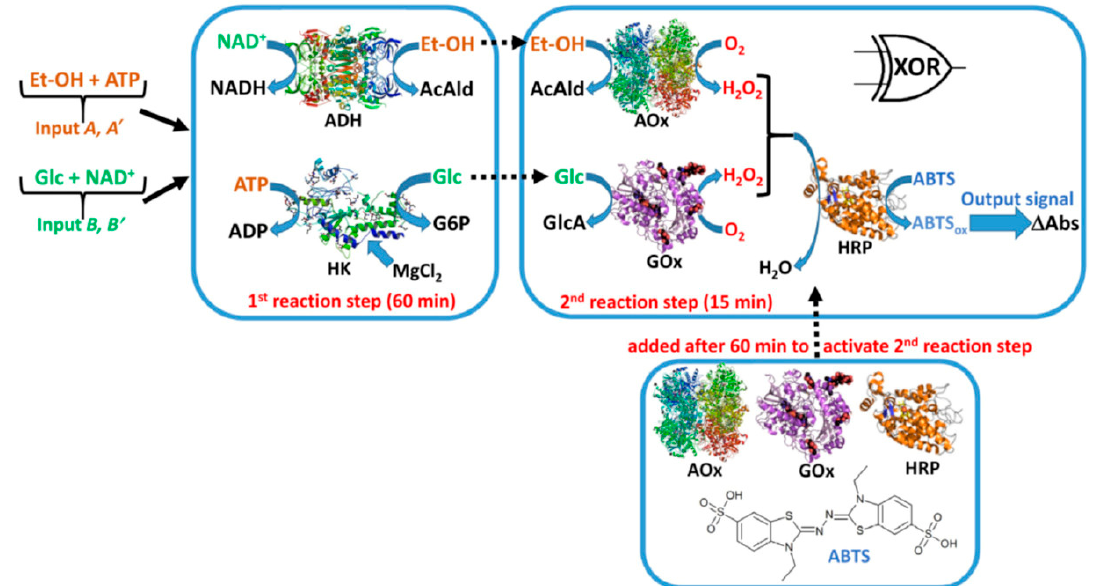
Figure 4. An enzyme cascade to model an XOR gate. When both inputs are provided (EtOH/ATP and Glc/NAD + ), the required substrate and cofactor are available for the ADH and HK enzymes, resulting in the removal of the required substrate for the second series of enzymes, AOx and GOx, and no production of H 2 O 2 . However, if only one of the inputs is provided, the EtOH or Glc substrates for AOx or GOx, respectively, will be available for H 2 O 2 production. The figure was adapted with permission from [75].